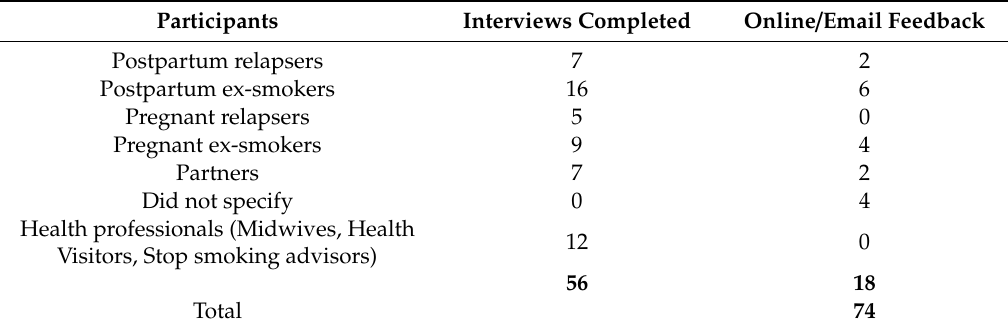
Table 1. Qualitative study participants.